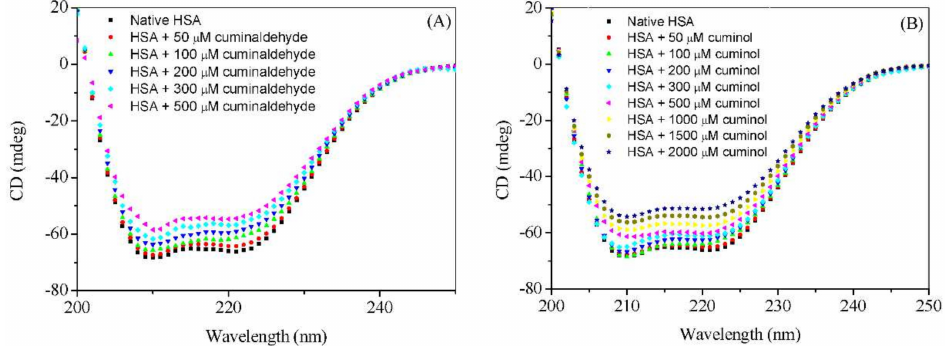
Figure 9. Far– UV CD spectra of HSA (3 µ M) in absence and presence of ( A ) cuminaldehyde and ( B ) cuminol at 25 ◦ C.